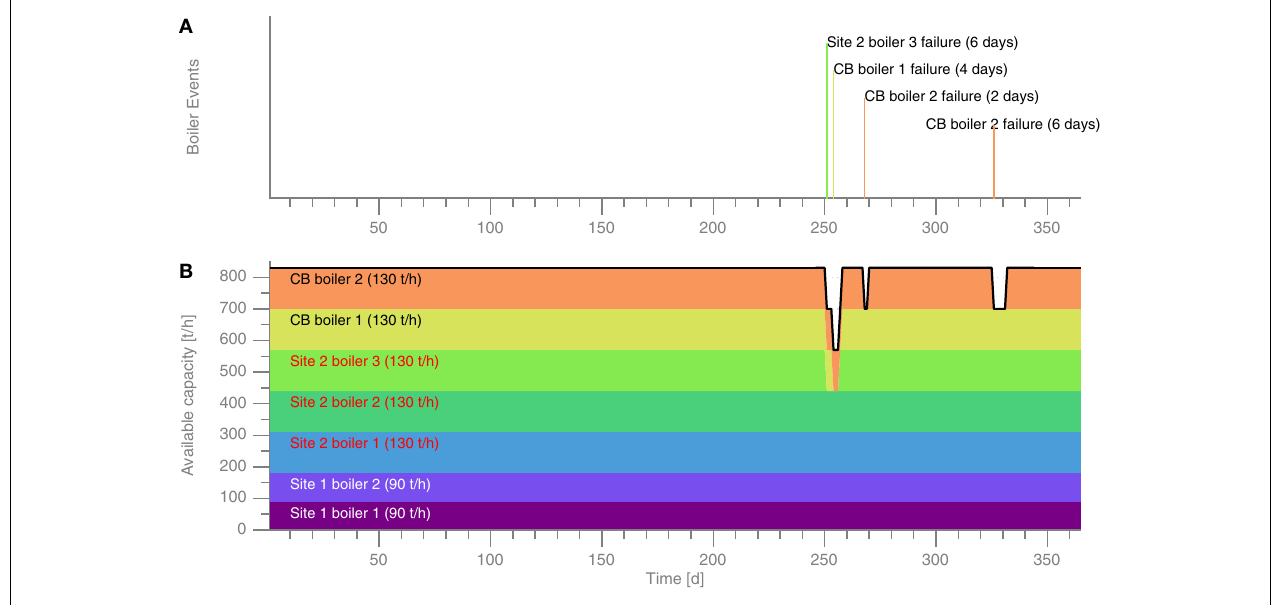
FIGURE 1 | Simulated boiler failures . Random boiler trips (A) and resulting available steam generation capacity (B) .